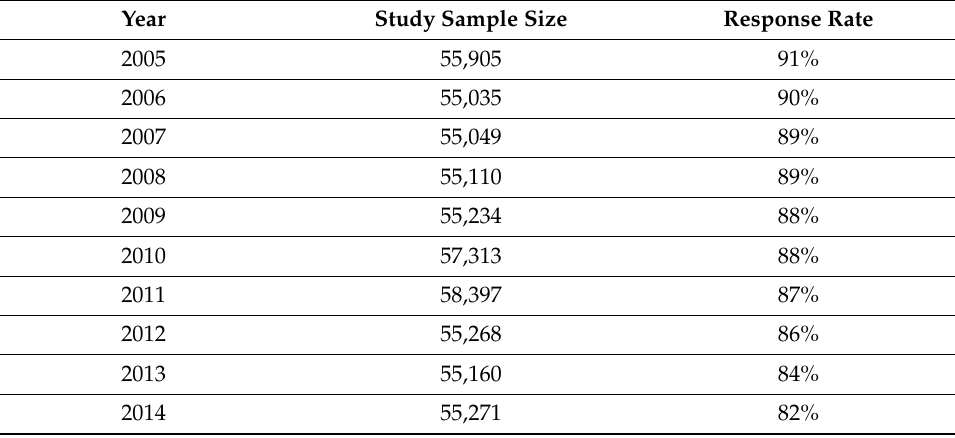
Table A1. Response rates and sample size of the NSDUH survey by year of collection.